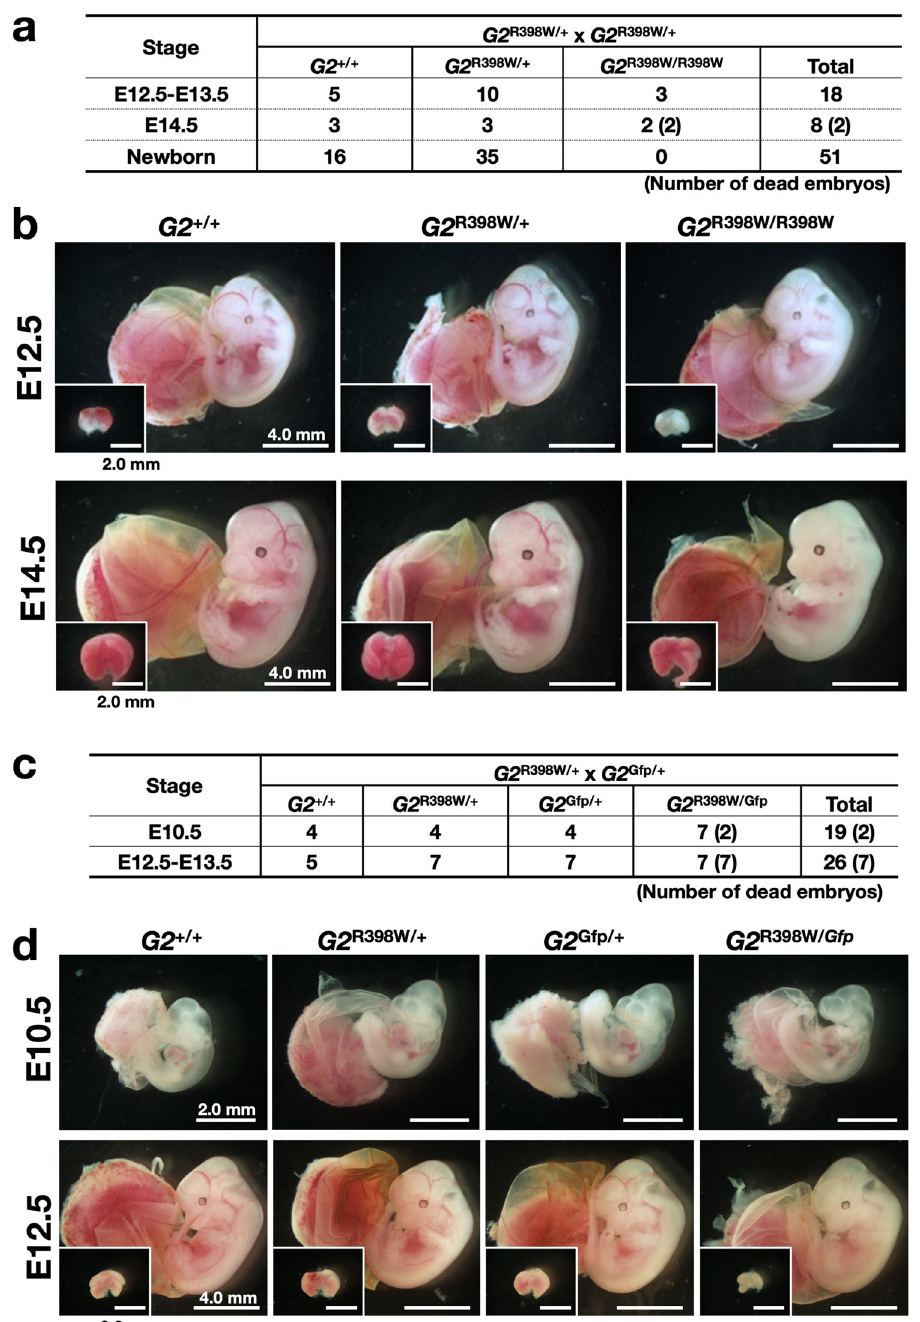
Fig. 2 Allele number-dependent effect of G2 R398W on mouse embryogenesis. Intercrossing of G2 R398W/ + mice ( a , b ) and mating of fetuses with G2 Gfp/ + mice ( c , d ). The numbers of embryos of each genotype at the indicated stage are shown ( a , c ), along with representative photos ( b , d ). Livers are shown in the insets ( b , d ). The number of dead embryos is indicated by parentheses. Note that no live G2 R398W/Gfp embryo was found at